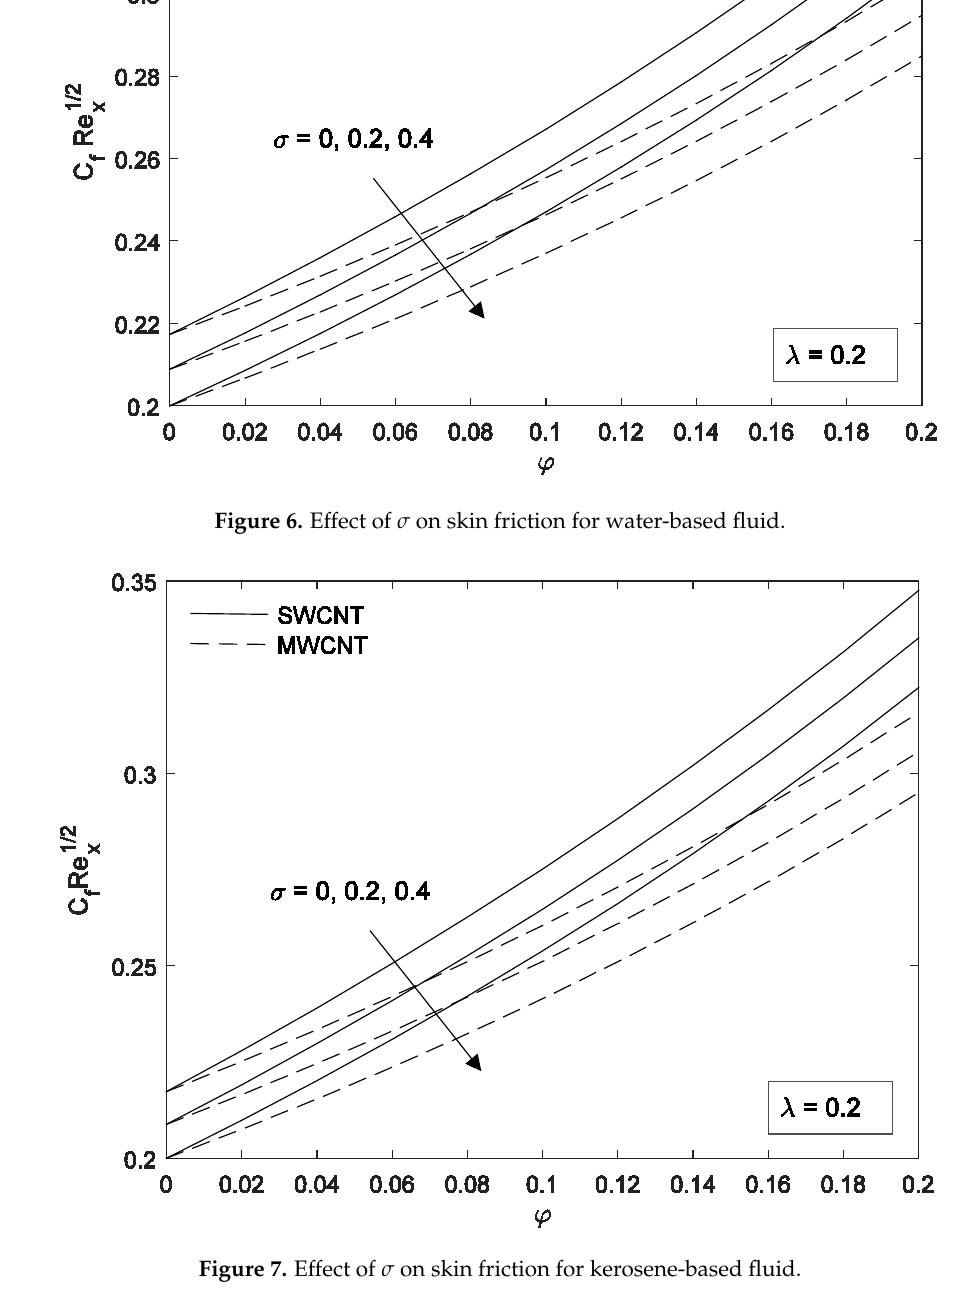
Figure 7. Effect of σ on skin friction for kerosene-based fluid.